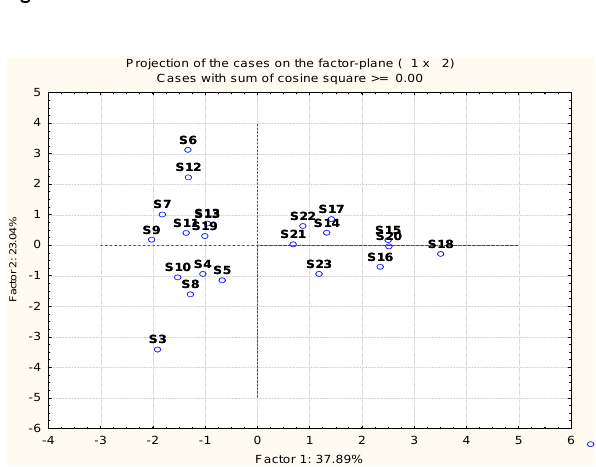
Fig. 4. PCA of variables. Figure 4 Results of the PCA of variables